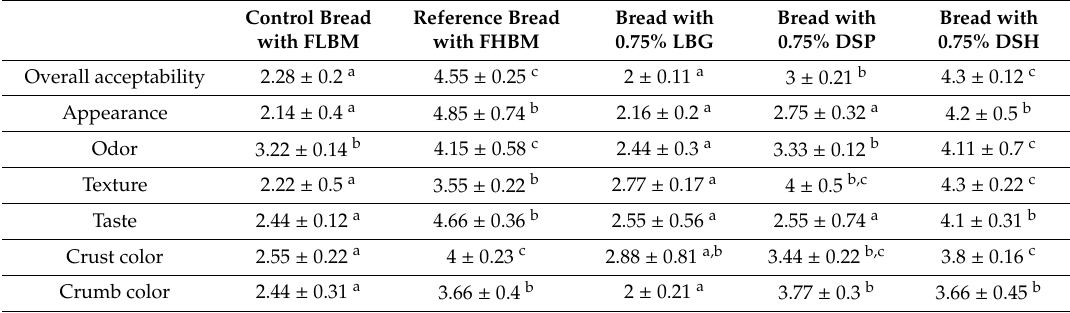
Table 6. Sensory evaluation of the di ff erent prepared bread. Control Bread with